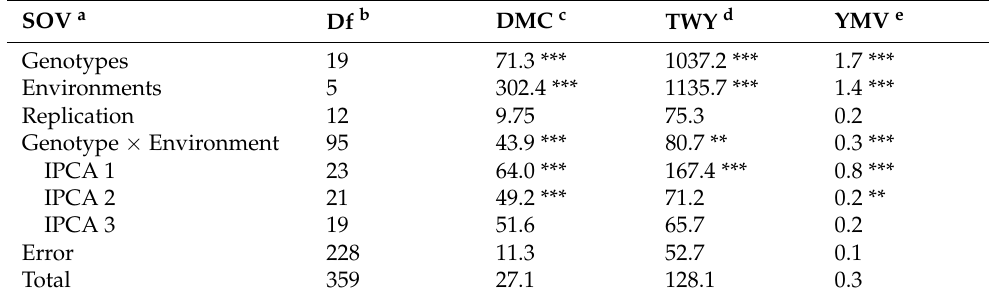
Table 9. AMMI analysis of 20 yam genotypes evaluated in six test environments within Uganda. SOV a Df